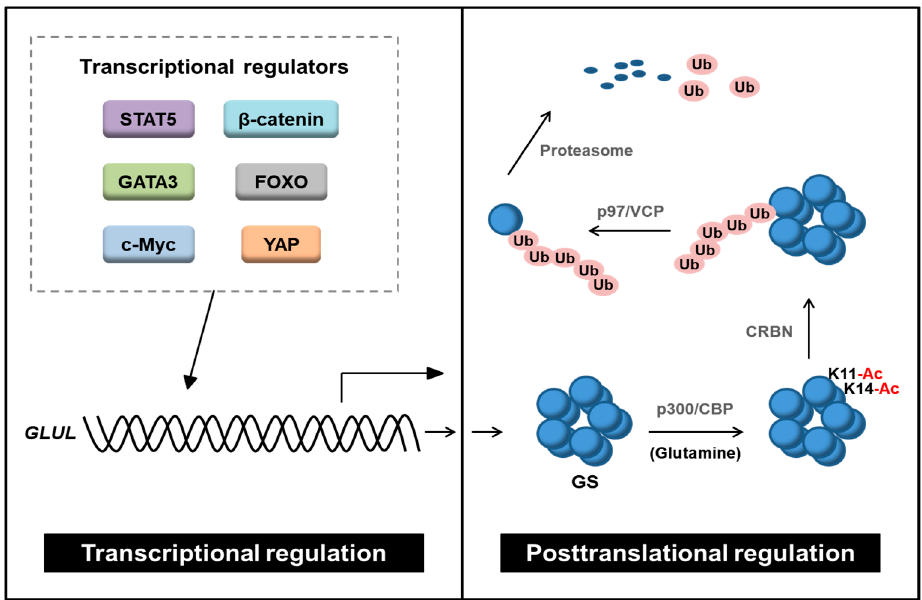
Figure 3. Transcriptional and posttranslational regulation of GS. GS is transcriptionally regulated by β -catenin, STAT5, GATA3, FOXO, YAP, and c-Myc. GS protein stability is regulated by acetylation. GS is acetylated by histone acetyltransferase, p300/CBP, and acetylated GS is ubiquitinated by the E3 ligase, CRBN. Ubiquitinated GS is segregated by p97/VCP and then degraded by the proteasome. STAT5: signal transducer and activator of transcription 5, GATA3: GATA Binding Protein 3, YAP: yes-associated protein, FOXO: members of the class O of forkhead box transcription factors, GS: glutamine synthetase, CBP: cyclic AMP response element-binding protein, CRBN: cereblon, Ub: ubiquitin, p97/VCP: valosin-containing protein.